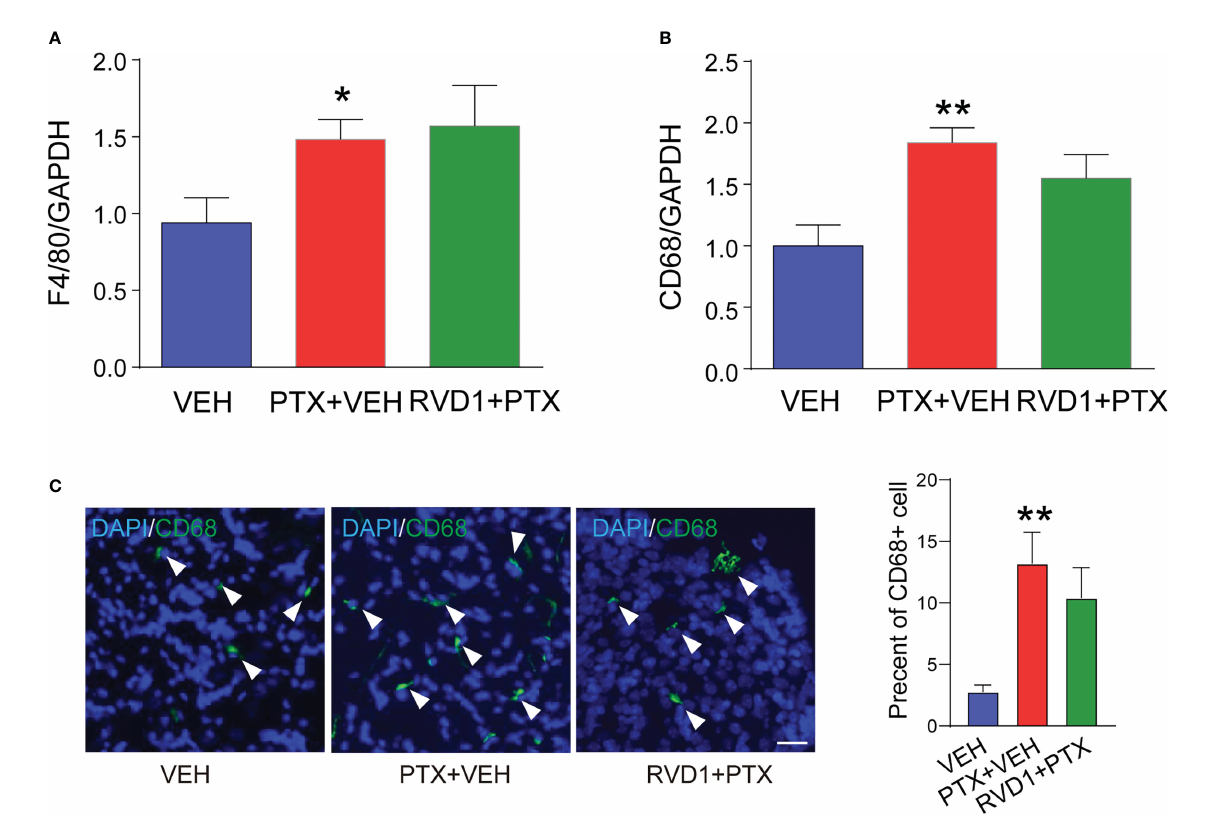
FIGURE 4 RvD1 did not affect the in fi ltration of macrophages in DRG under PINP condition. The mRNA of mouse DRG tissue was extracted 14 days after PTX injection. The expression of macrophage markers F4/80 (A) and CD68 (B) mRNA was detected by qPCR, and the CD68 positive cells (C) in DRG were detected by immuno fl uorescence technique. *p < 0.05, **p < 0.01 vs CON group. n=4. Scale bar: 50 m m. RvD1, resolvin D1; PTX,